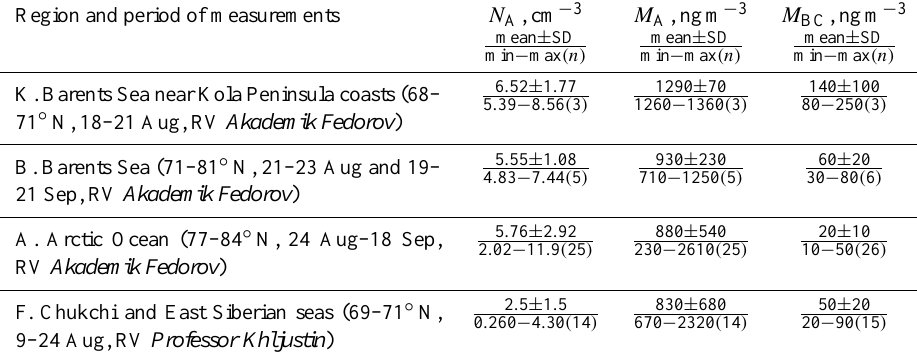
Table 4. Statistical characteristics of near-water aerosol in Arctic seas: the numerator indicates mean and standard deviation ( ± SD); and the denominator indicates the minimum (min) and maximum (max) values, and the number of days of measurements ( n ). Region and period of measurements N A , cm − 3